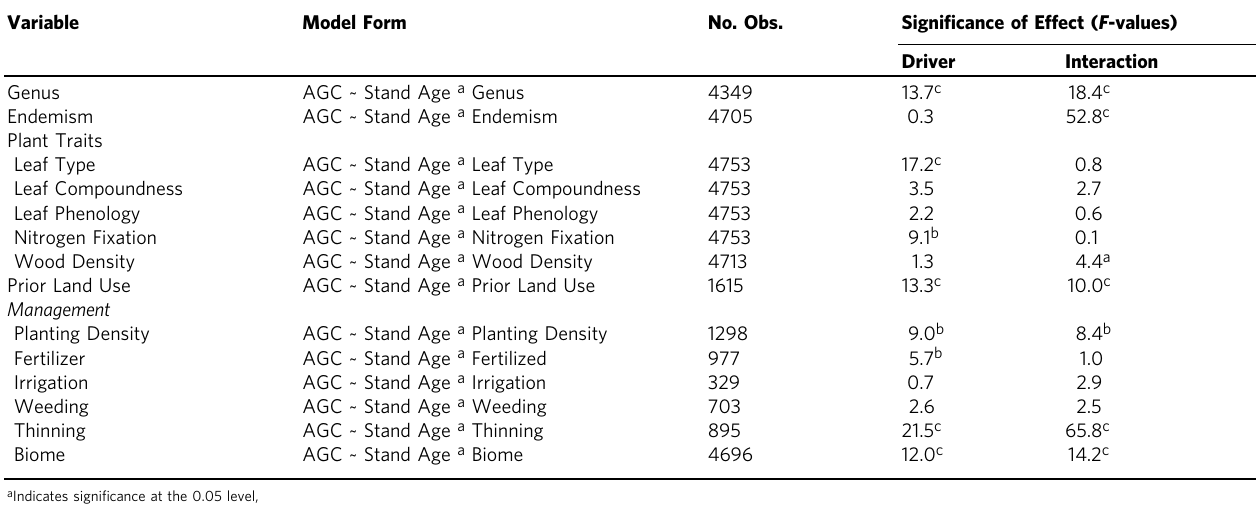
a Indicates signi fi cance at the 0.05 level, b indicates signi fi cance at the 0.01 level, and c indicates signi fi cance at the 0.001 level. Aboveground carbon (AGC) and stand age are square root transformed in all models. Signi fi cance was determined using two-sided F-tests with Satterthwaite approximations of degrees of